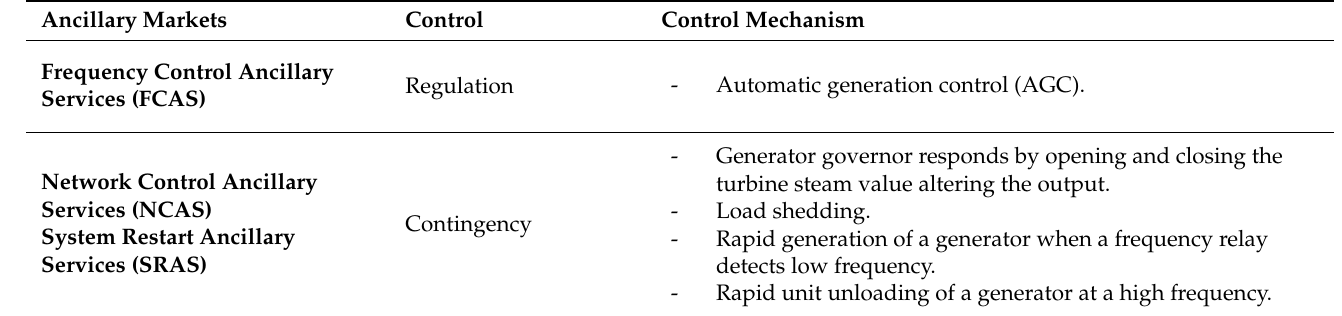
Table 4. Ancillary markets in